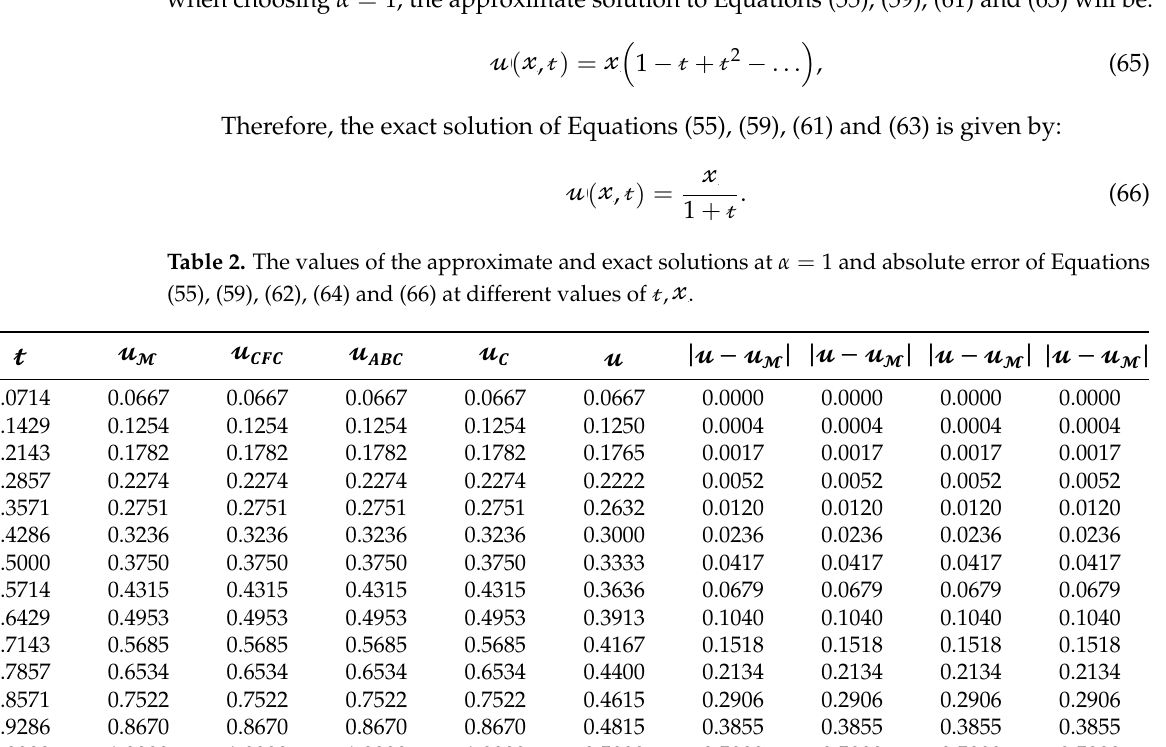
Table 2. The values of the approximate and exact solutions at 𝛼 = 1 and absolute error of Equa- tions (55), (59), (62), (64) and (66) at different values of 𝓉, 𝓍 .